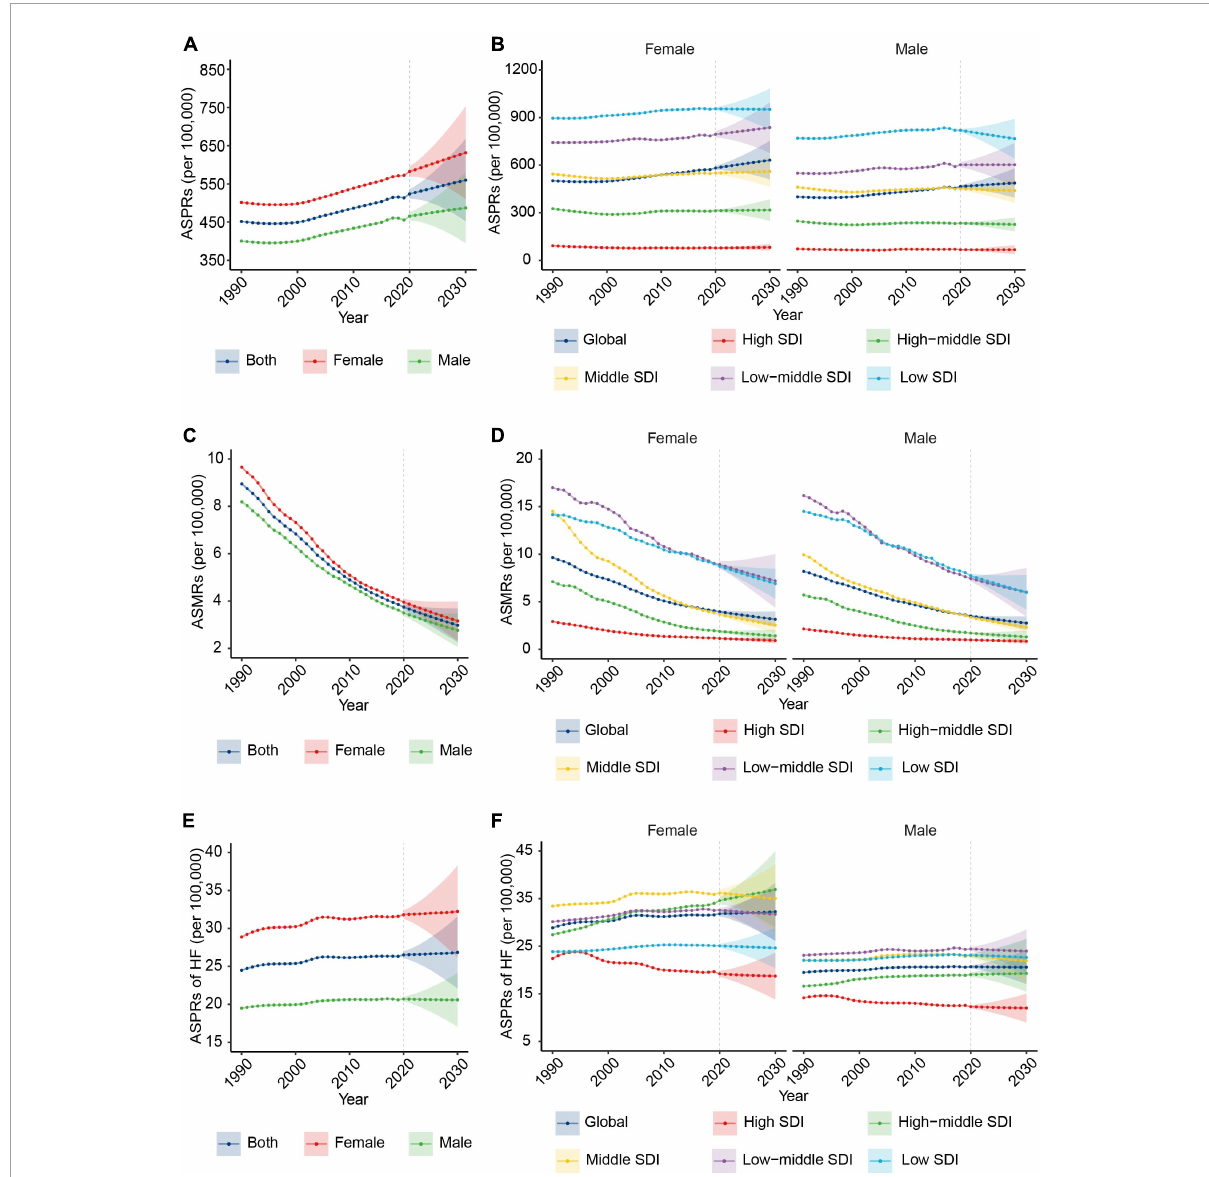
FIGURE3 The change trends of the RHD-related disease burden by sex from 1990 to 2030. (A) The ASPRs from 1990 to 2030 at the global level by sex. (B) The ASPRs at the global level and in different SDI regions by female (the left) and male (the right) subjects. (C) The ASMRs from 1990 to 2030 at the global level by sex. (D) The ASMRs from 1990 to 2030 at the global level and in different SDI regions by female (the left) and male (the right) subjects. (E) The ASPRs of HF from 1990 to 2030 at the global level by sex. (F) The ASPRs of HF from 1990 to 2030 at the global level and in different SDI regions by female (the left) and male (the right) subjects. RHD, rheumatic heart disease; ASPRs, age-standardized prevalence rates; SDI, sociodemographic index; ASMRs, age-standardized mortality rates; HF, heart